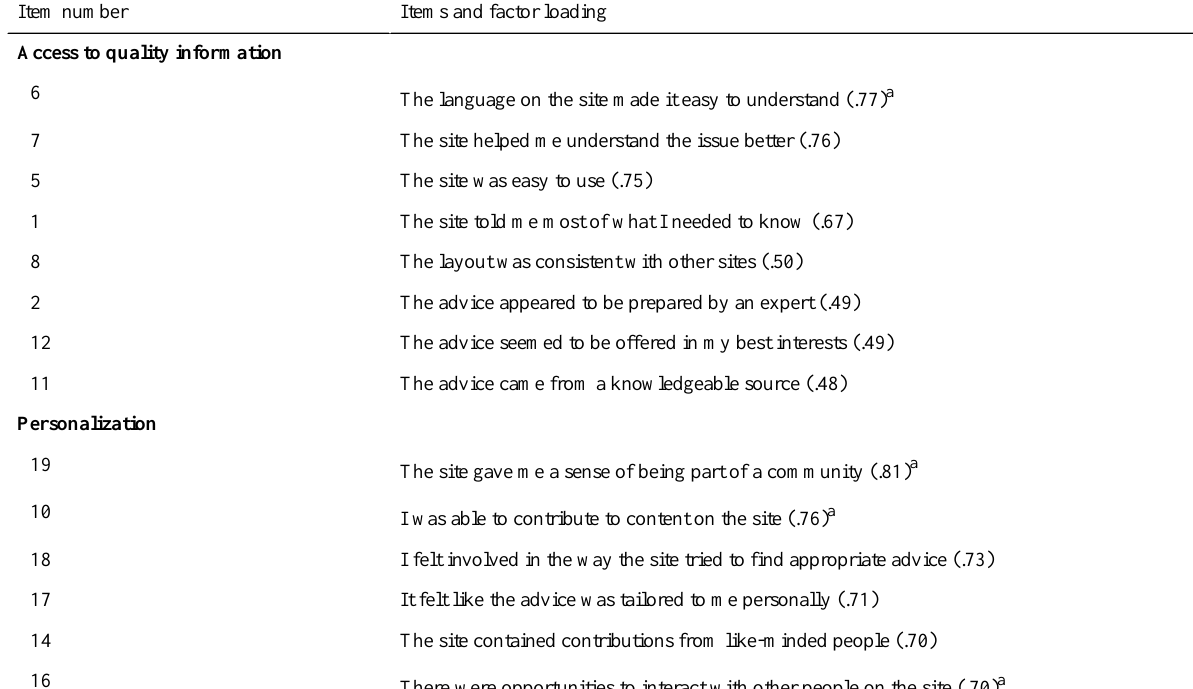
Items and factor loadingItem number